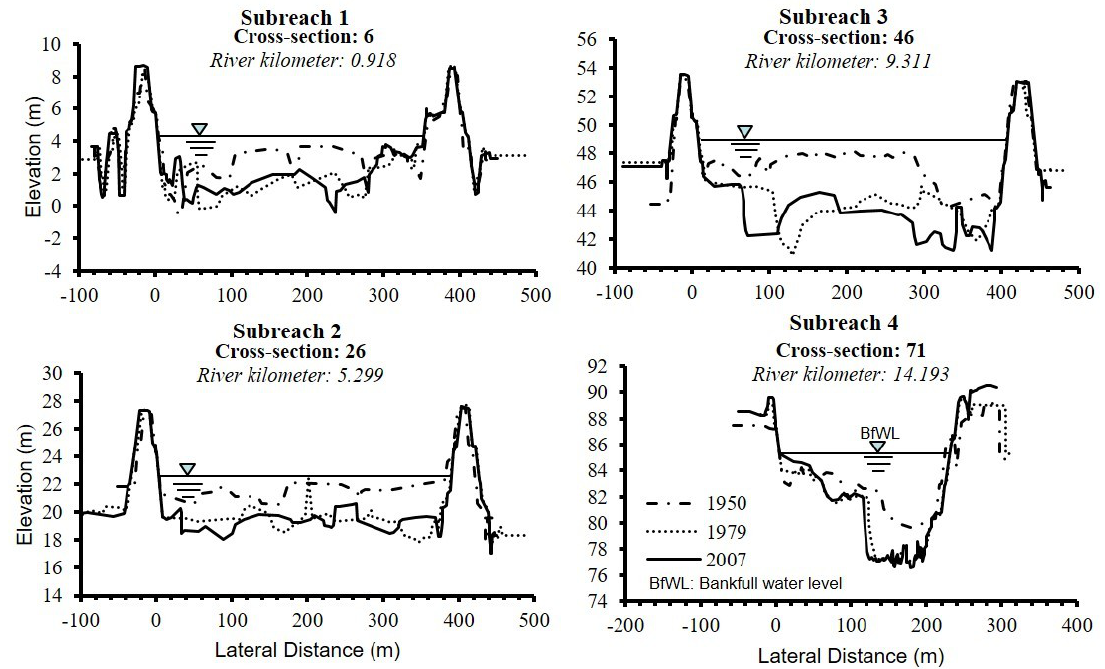
Figure 6. Superimposed cross-sectional profiles of the Tedori River at four cross-sections for 1950, 1979, and 2007. (River kilometers mentioned here are referred from the river mouth. Elevation was measured relative to Tokyo Peil (TP), the standard ground elevation in Japan based on the mean sea level of Tokyo Bay).